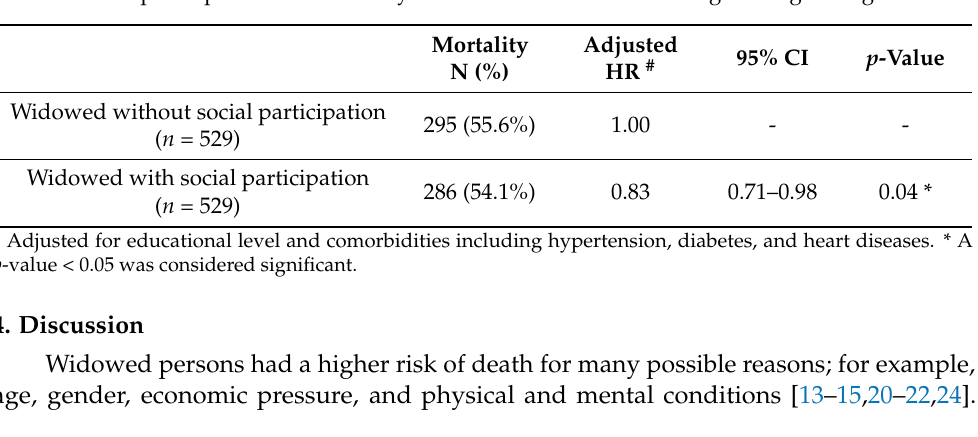
Table 4. Social participation and mortality in the widowed after matching with age and